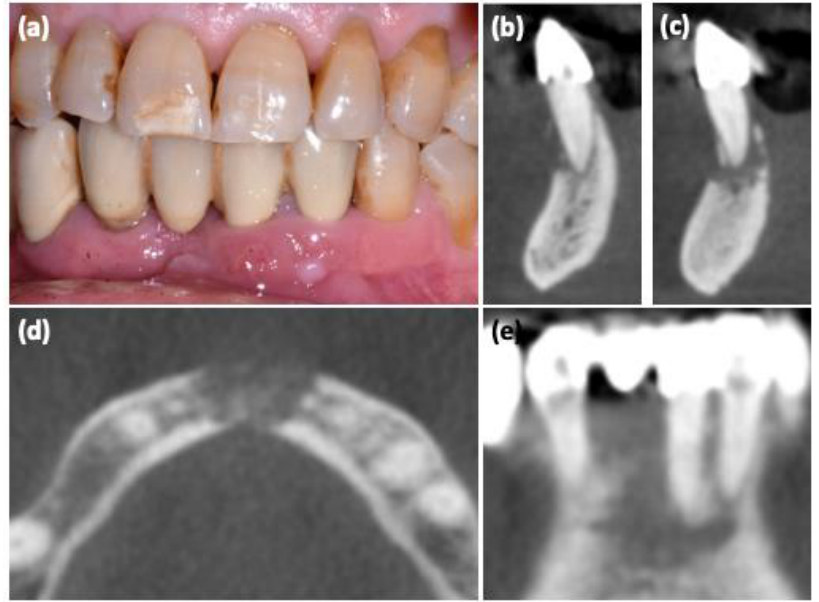
Figure 2. MRONJ stage I, lower jaw: ( a ) clinical view; ( b – e ) computed tomography scan sections.